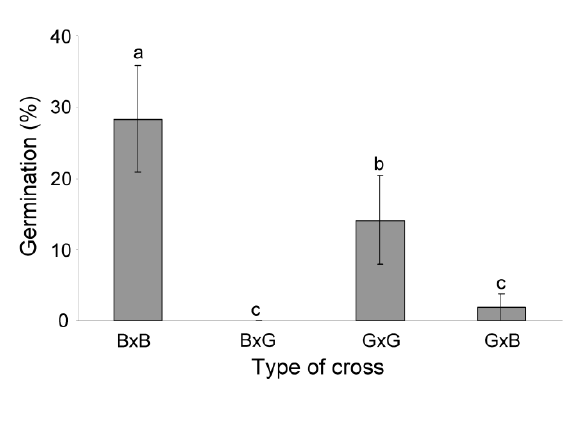
F IG . 3. Mean percentage of germination (± SE) for the conspecific (B×B and G×G) and interspecific (B×G and G×B) crosses. Different letters above columns indicate significant differences among species (Sequential Bonferroni test, P <